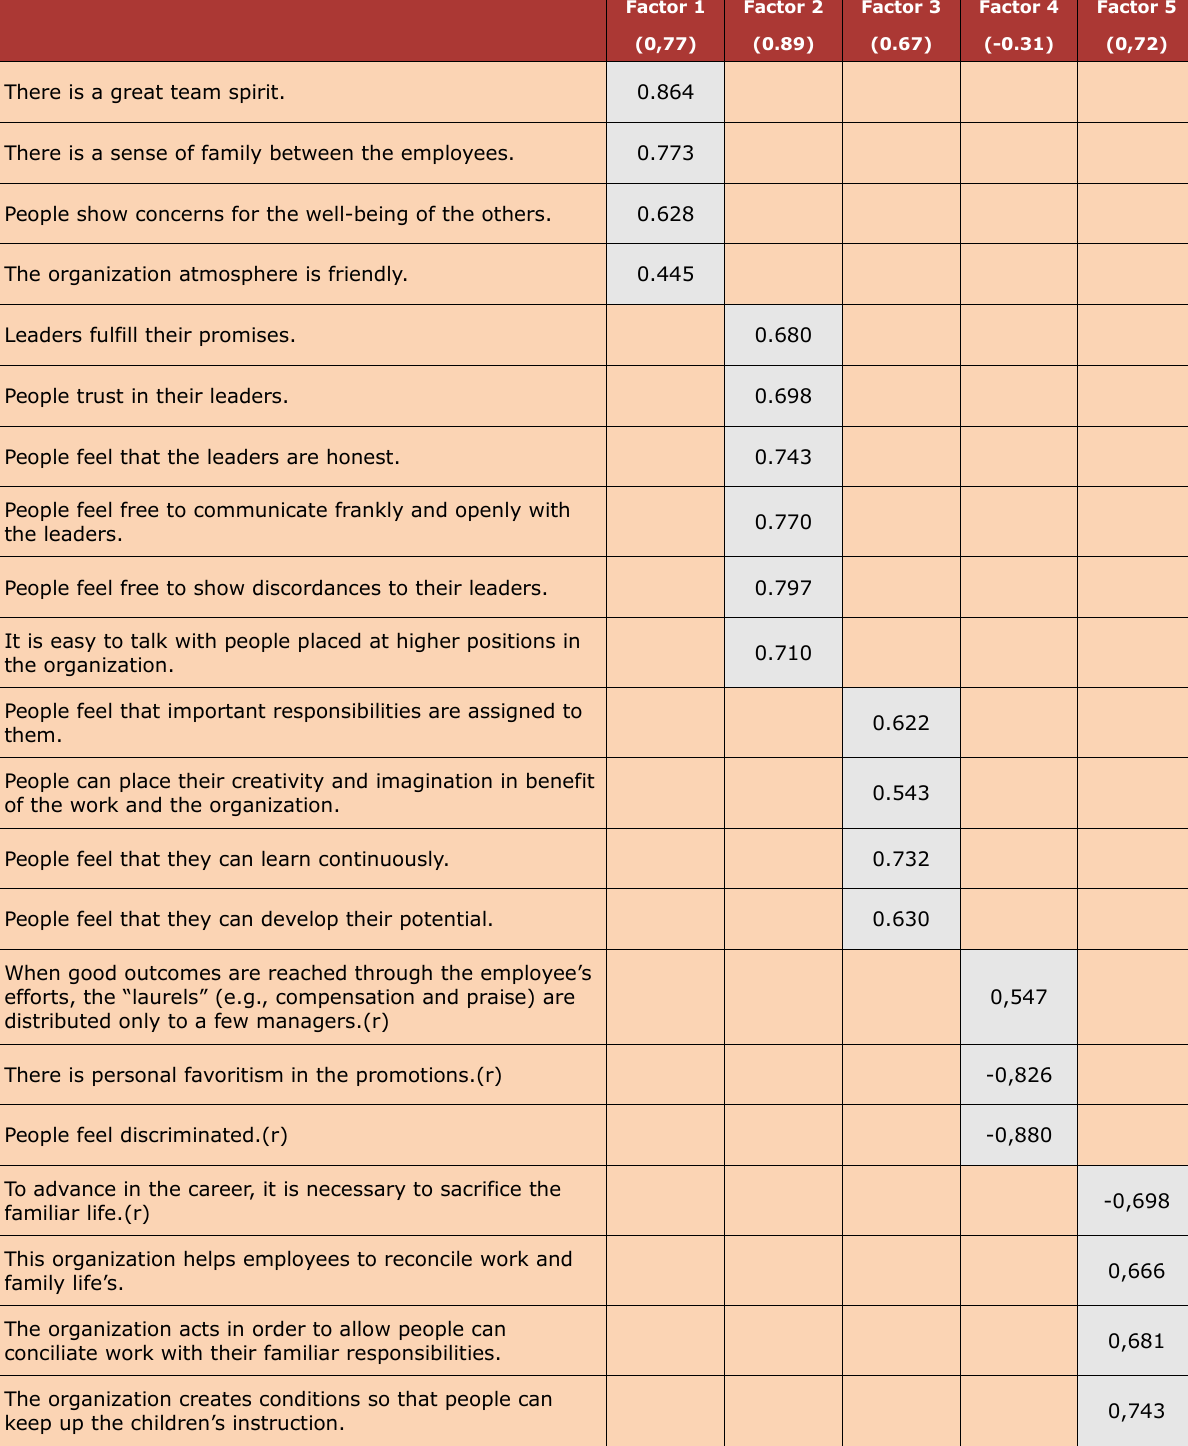
Table 3. Authentizotic organizational dimensions. Exploratory factor